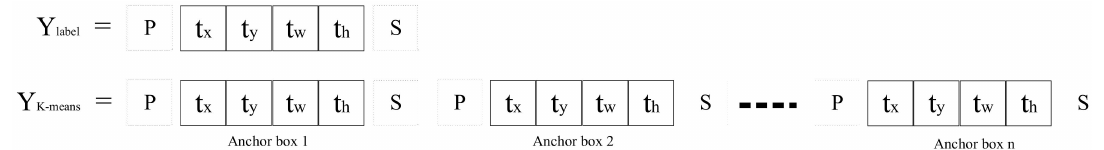
Figure 4. Encoding bounding box with multiple anchor box after k-means